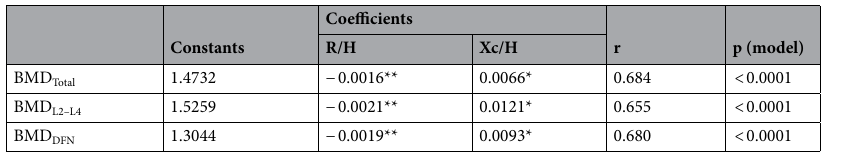
Table 2. Results from the GLM regression analysis showing similar associations between resistance and reactance standardized for height and bone mineral density. All distributions of residuals were compatible with a normal distribution. *p < 0.05. **p <